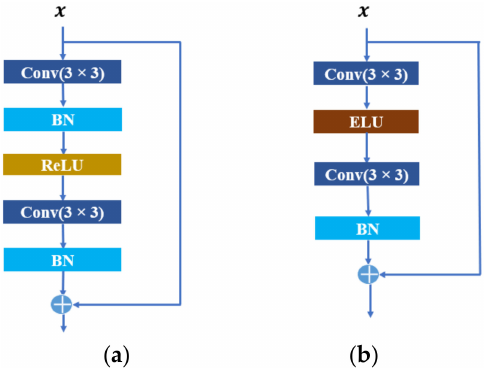
Figure 1. Original and modified residual blocks: ( a ) original residual block; ( b ) modified residual block.